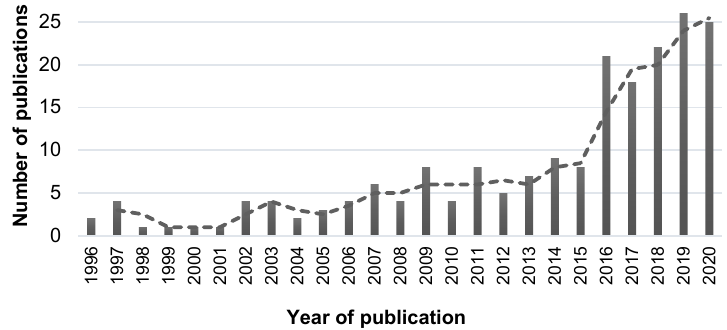
Figure 1. Number of publications (within the review’s scope) by year, in absolute value.